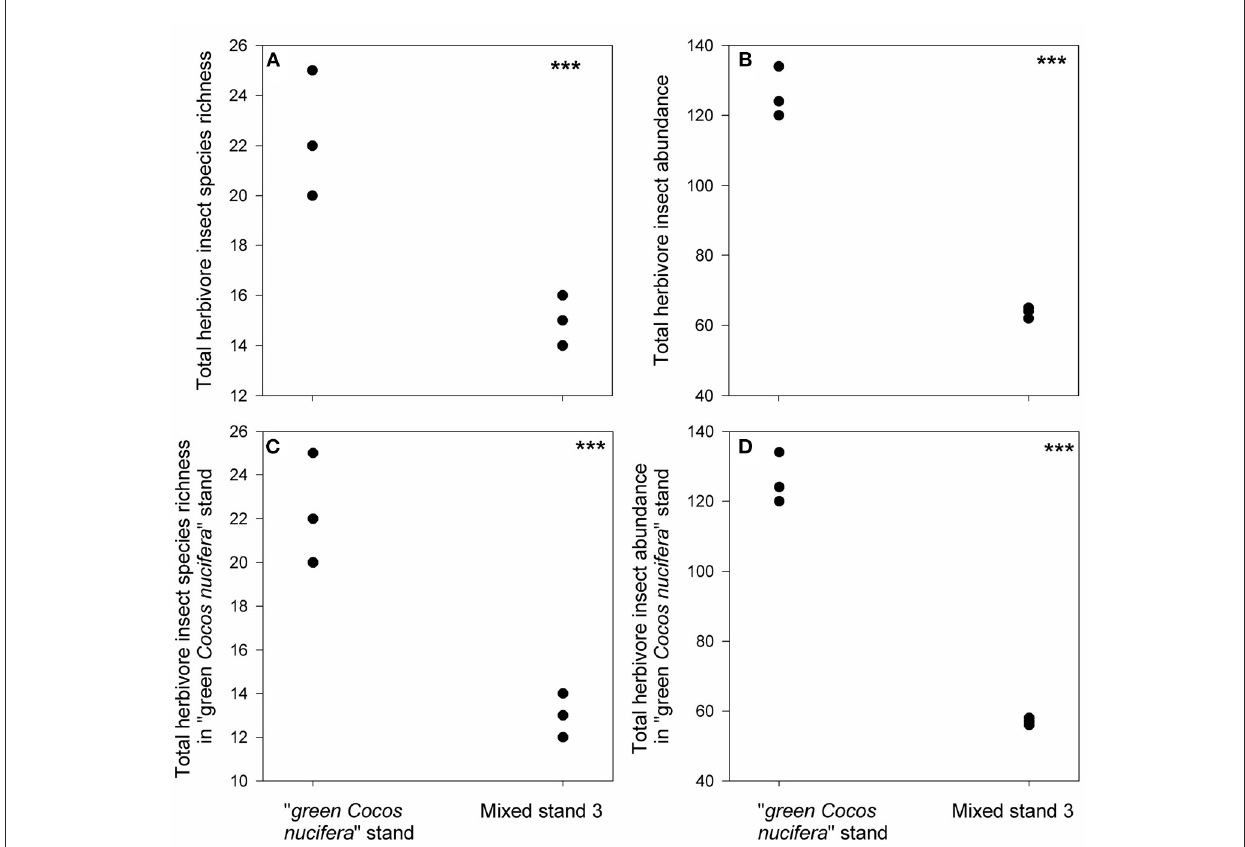
FIGURE4 Differences in total herbivore insect species richness (A) , total herbivore insect abundance (B) , total herbivore insect species richness in “green Cocos nucifera ” stand (C) and their abundance (D) between mixed stand 3 and “green Cocos nucifera ” stand. *** indicates p < 0.05, results from our generalized linear mixed effect model with Poisson